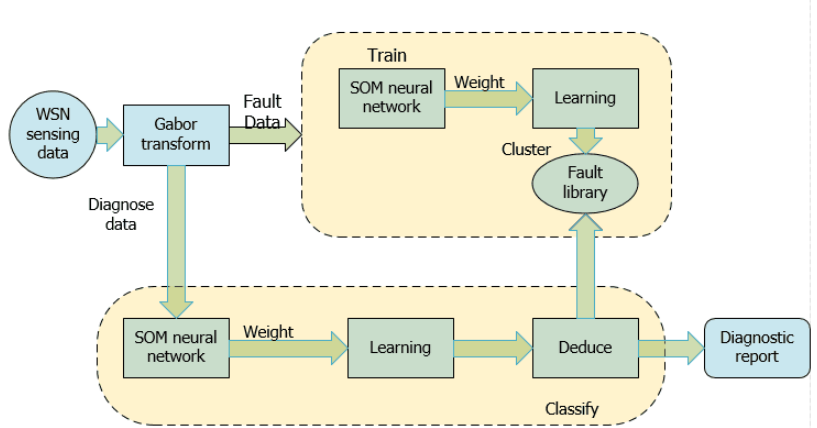
Figure 9. Passive approach: Process of inference model following